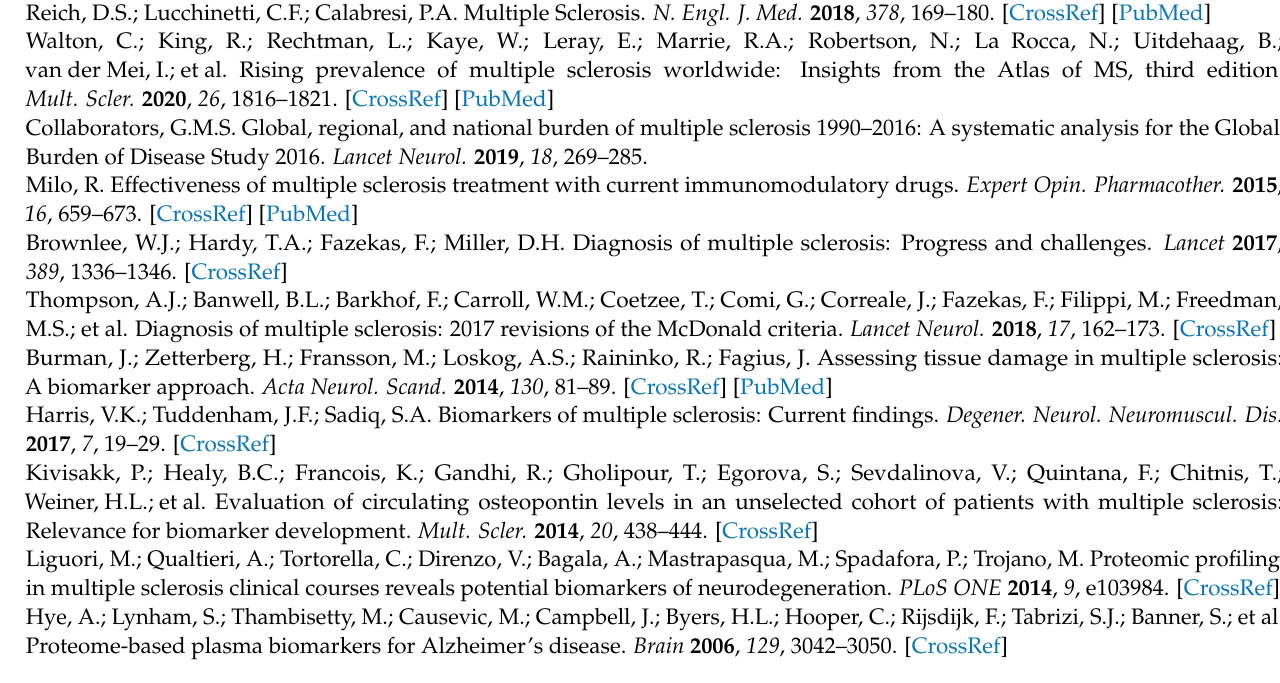
ters of HC and MS groups; Table S5: ROC analysis for individual TLB-associated parameters; Table S6: Summary of the application of binomial generalized linear model with logistic regression (GLM) to the three models; Table S7: model comparison based on the likelihood ratio test; Table S8: TLB score (model 3) vs. gender and age; Table S9: TLB score (model 3) vs. clinical history information (EDSS, diagnosis stage, disease duration and therapy) for MS group. Table S10: Contingency table for clinical history information (EDSS, diagnosis stage, disease duration, and therapy) for MS group (using TLB score from model 1); Table S11: contingency table for clinical history information